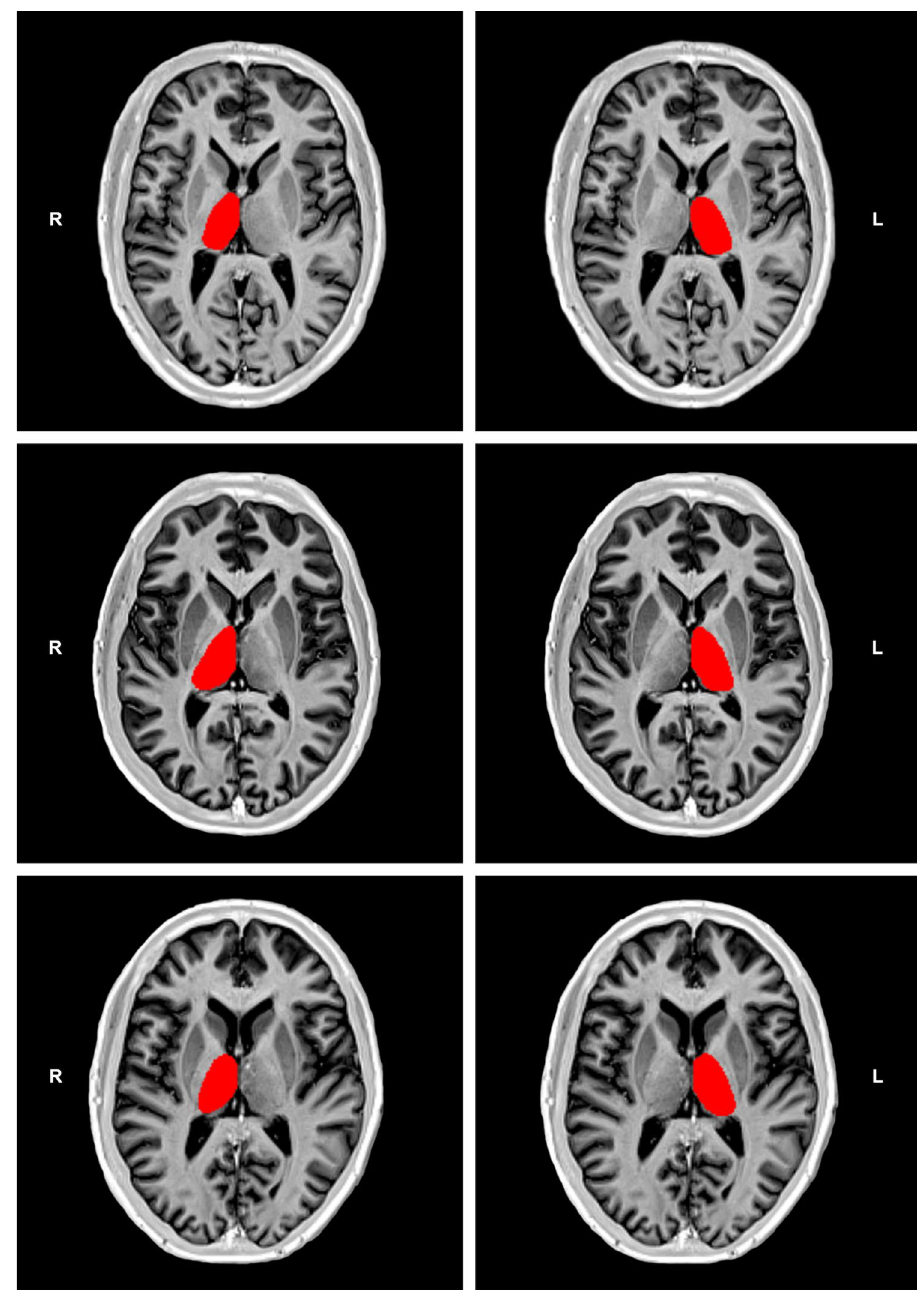
Figure 1. Examples of thalamic segmentation on bias corrected inversion recovery (IR) turbo spin echo (TSE) T1-weighted images (T1-WI) from one patient with nonpainful diabetic peripheral neuropathy (DPN) in the top row and one patient with painful DPN in the middle row. In the bottom row, an example of a similar segmentation procedure on a 46-year-old healthy subject is shown. This example is presented for visualization purposes only, and was randomly selected from a sample of a previous study using similar IR TSE T1-WI to segment deep gray matter structures 11 . Please note the apparent reduction of thalamic volume (especially the thinner cross-sectional thalamic distance) in the patient with nonpainful DPN, especially in the right thalamus, relative to the other